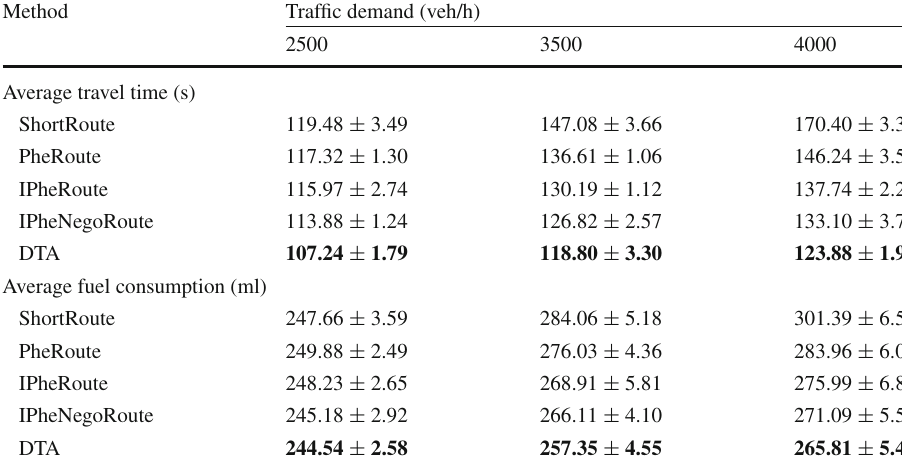
Table 2 Numerical results of traffic routing methods in the Yeouido island traffic network